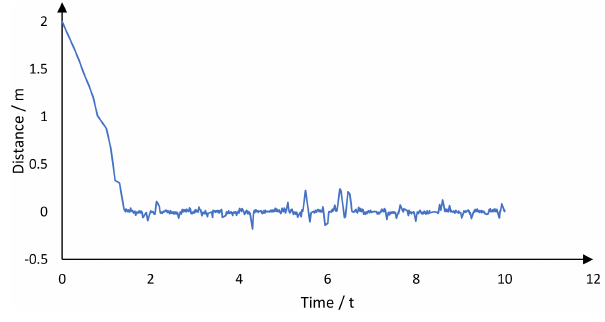
Figure 8. Chattering of